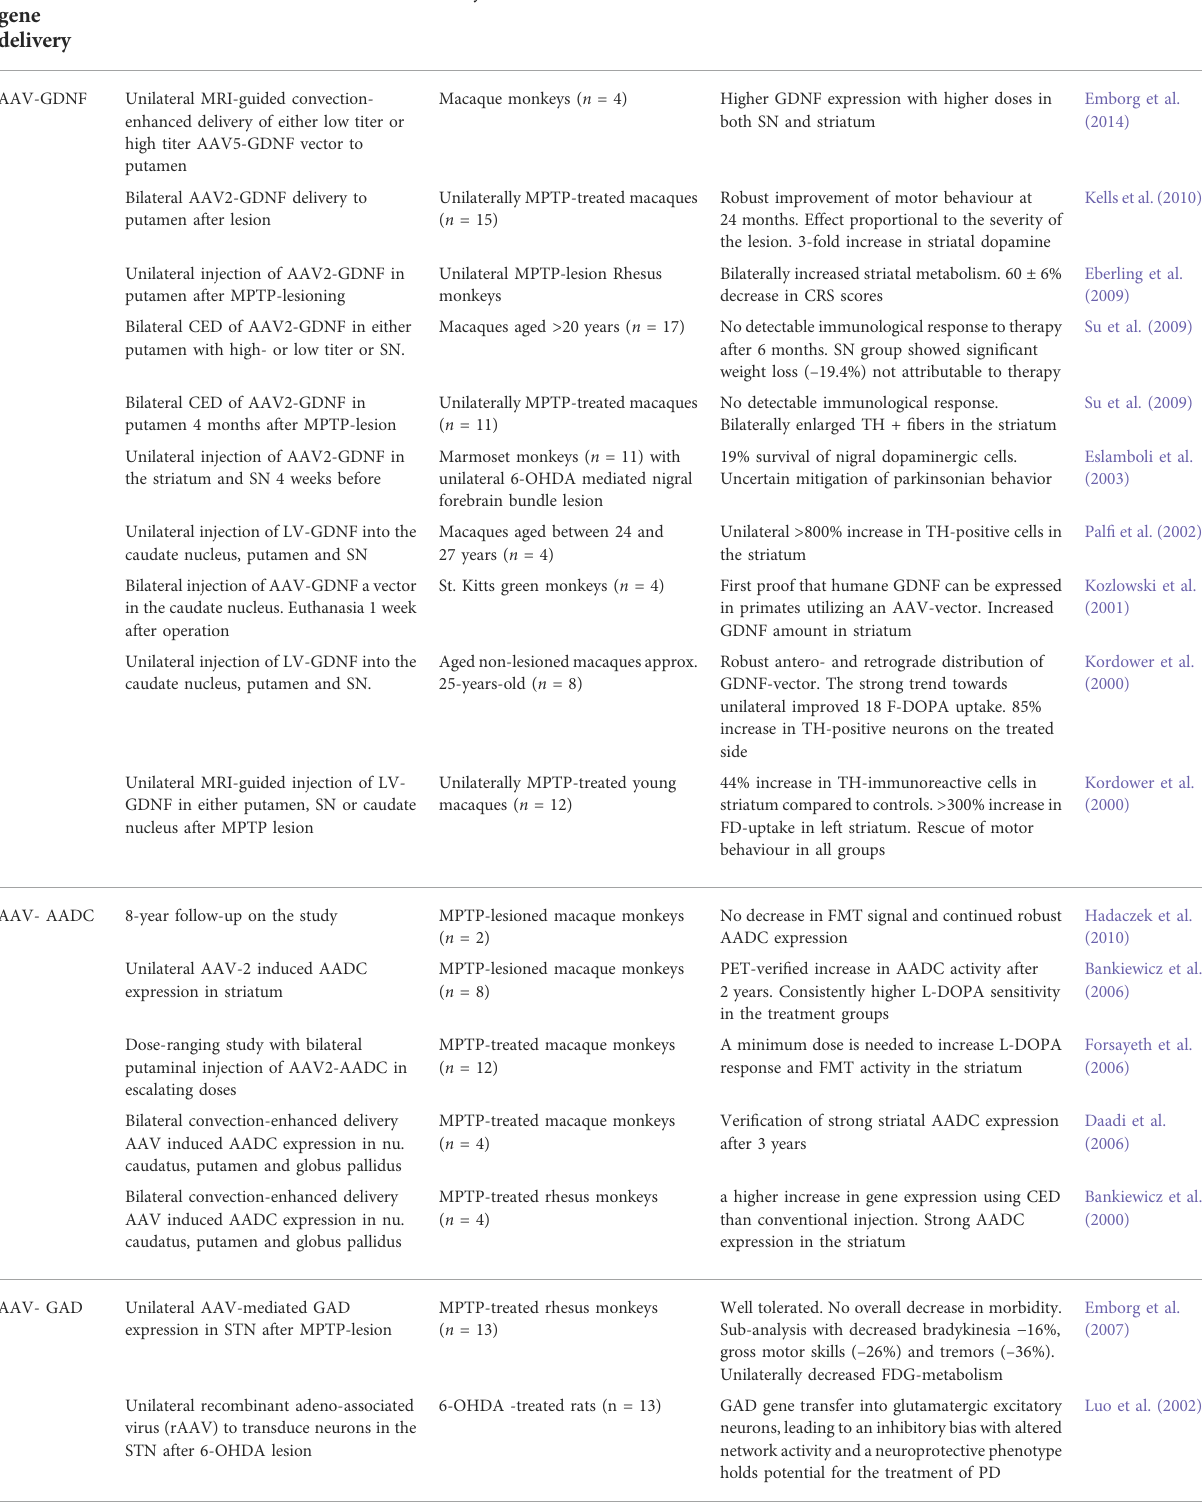
TABLE 2 Preclinical data of gene therapy for Parkinson ’ s